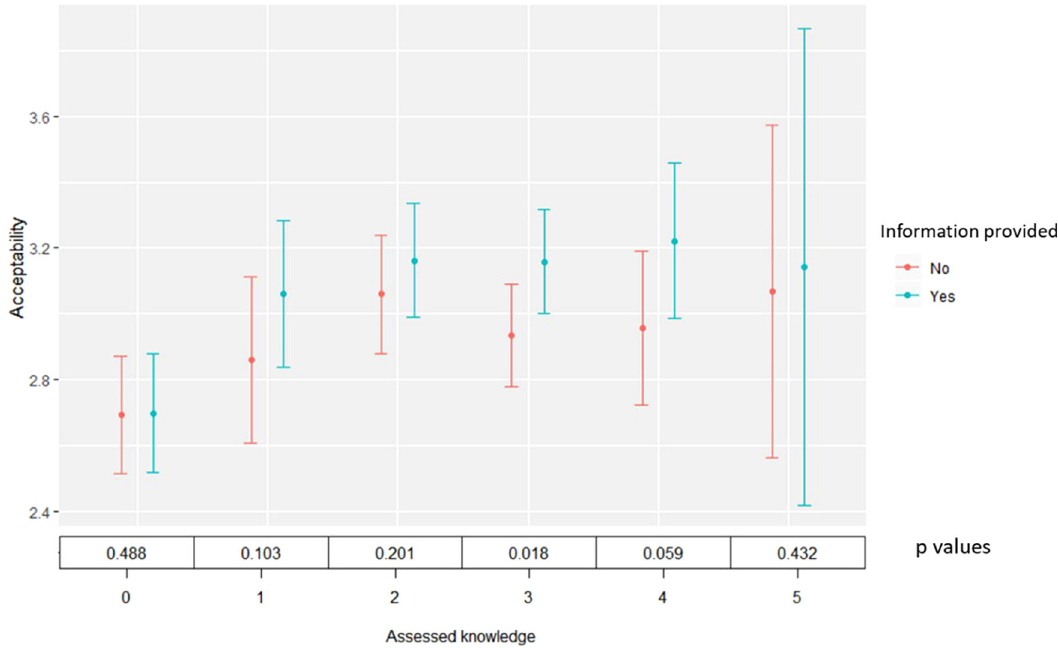
Fig. 3 Relationship between assessed knowledge and acceptability of a carbon tax with and without information provision, for unspeci fi ed revenue use. Results include averages and error bars depicting + / − 2 s.e. Acceptability is measured on a 5-point scale: 1 = completely unacceptable to 5 = completely acceptable. At the bottom are p -values of a Kruskal – Wallis rank-sum test with Bonferroni correction for statistical differences between the two subsamples. Subgroup sizes are: N = 353 for assessed knowledge equalling 0, N = 256 for assessed knowledge equalling 1, N = 488 for assessed knowledge equalling 2, N = 600 for assessed knowledge equalling 3, N = 264 for assessed knowledge equalling 4, and N = 43 for assessed knowledge equalling